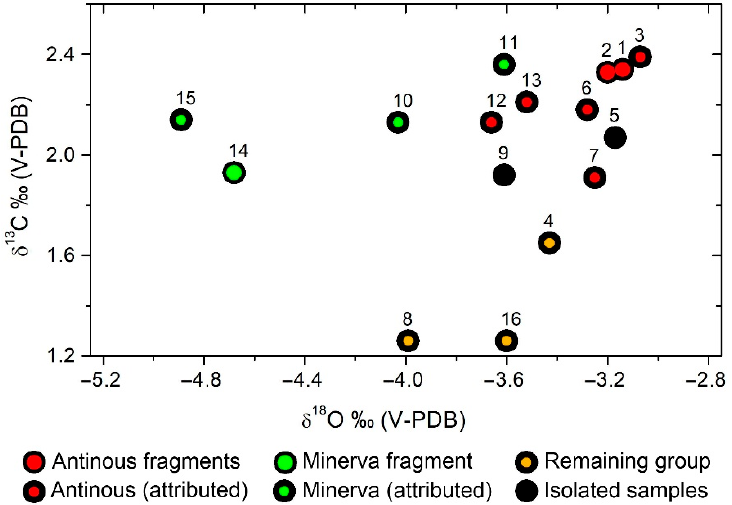
Figure 6. Detail of the isotopic results shown in Figure 3, here coloring the samples according to discussed attributions. Black dots correspond to samples of fragments not linked to any other frag- ment.